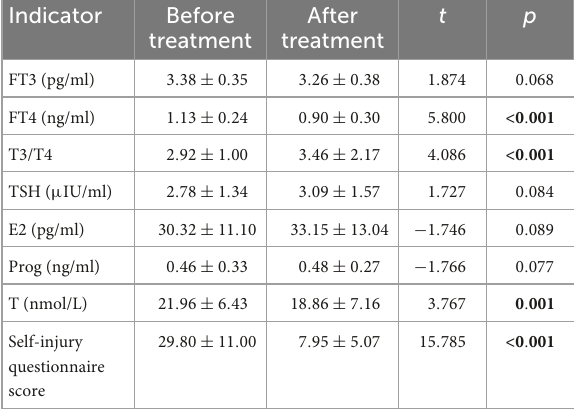
TABLE 2 Comparison of the indexes before and after treatment in the non-suicidal self-injury (NSSI) group. Indicator Before After treatment